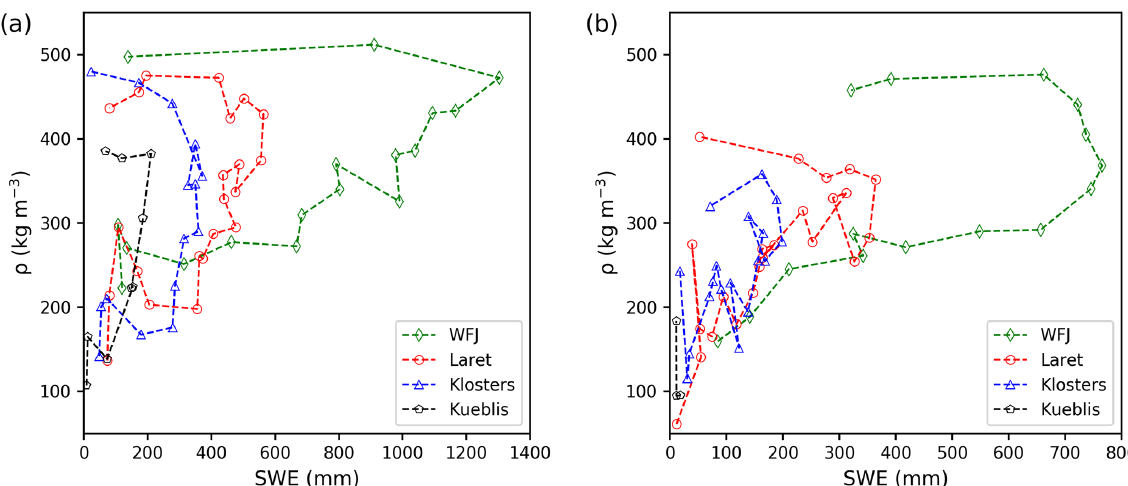
Figure A1. Seasonal evolution of snow density vs. SWE from manual measurements for (a) 2018–2019 and (b) 2019–2020 at the four sites Weissfluhjoch 2540ma.s.l., Laret 1510ma.s.l., Klosters 1185ma.s.l. and Küblis 820ma.s.l. Measurements were done weekly at the three lower-elevation sites and every 2 weeks at Weissfluhjoch.